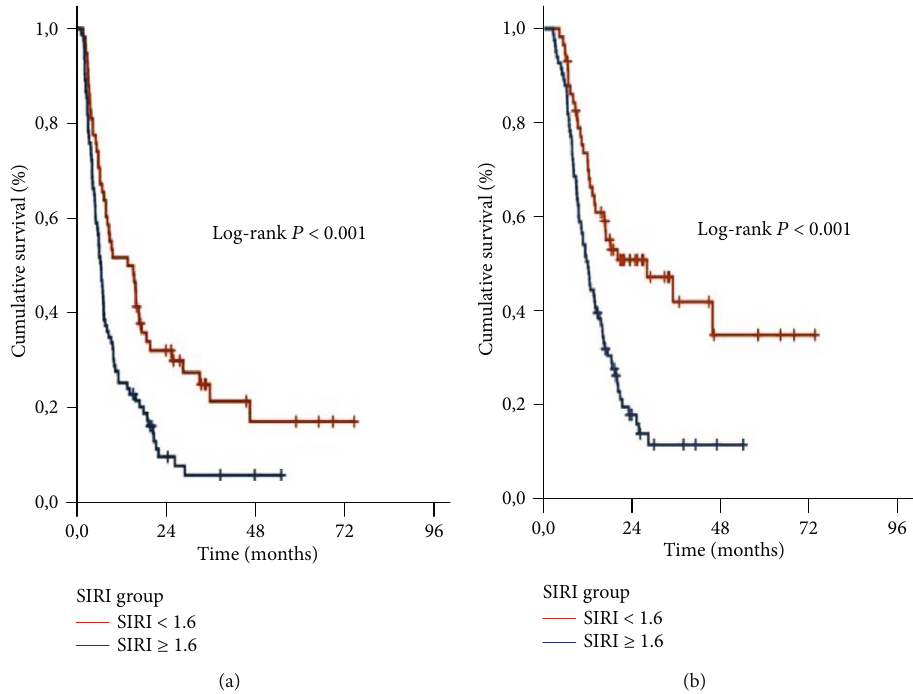
Figure 2: Survival outcomes per systemic in fl ammation response index (SIRI) groups: (a) progression-free survival, and (b) overall Table 2: Outcomes of uni- and multivariate analysis.